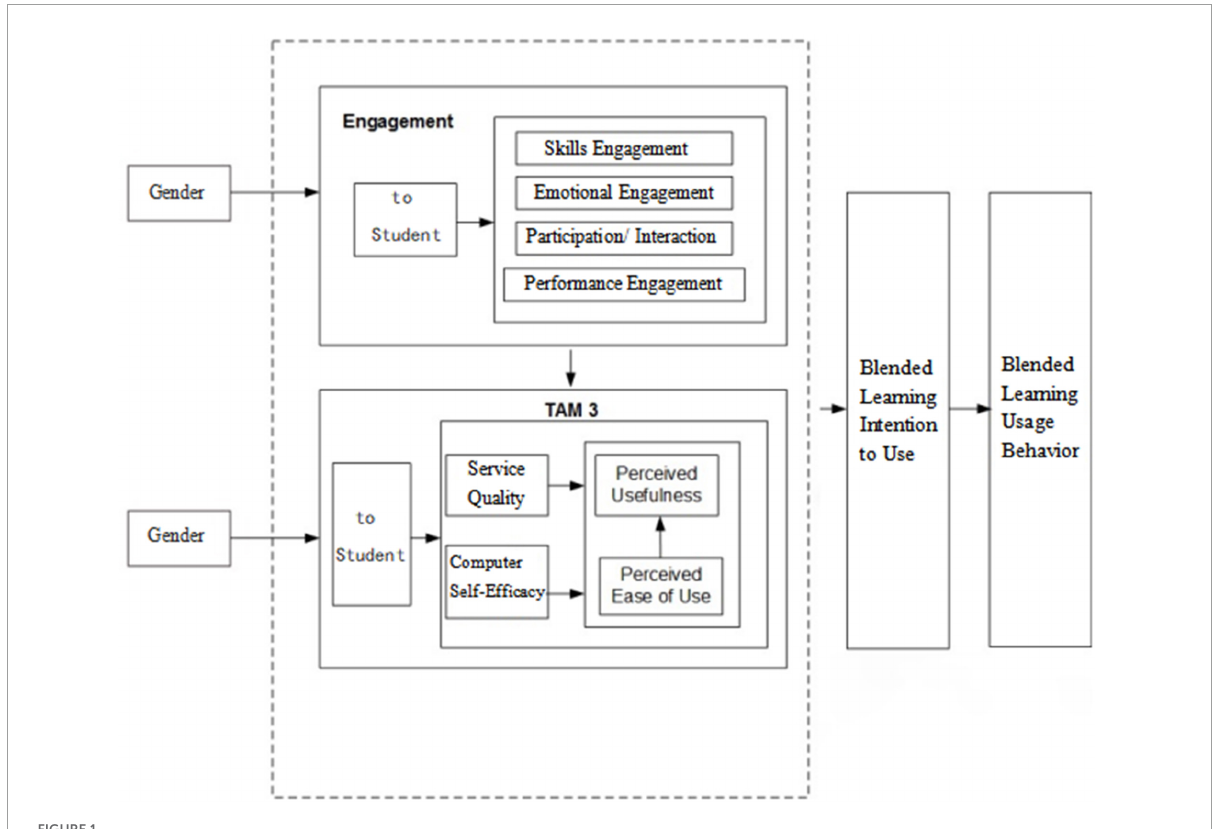
FIGURE1 Conceptual